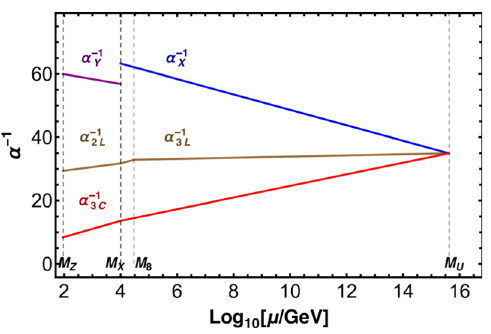
= M (solid curve), M = 3 M (dashed curve) and M = 10 M 8 X 8 X 8 X as a function of M , for the same X Y